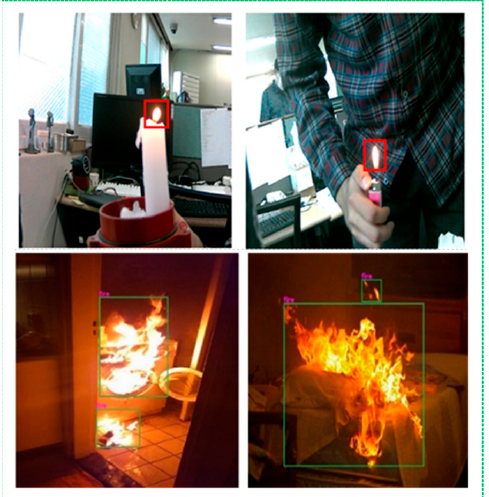
Sensors 2022 , 22 , x FOR PEER REVIEW Figure 4. Visible results of the proposed method for small size and multiple flame areas.